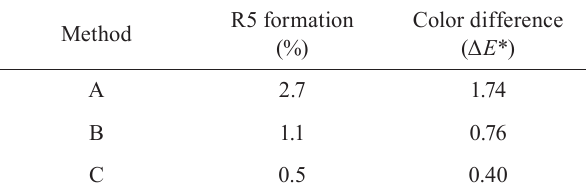
Table 4 R5 formation rate and color difference of risperidone OD tablets after